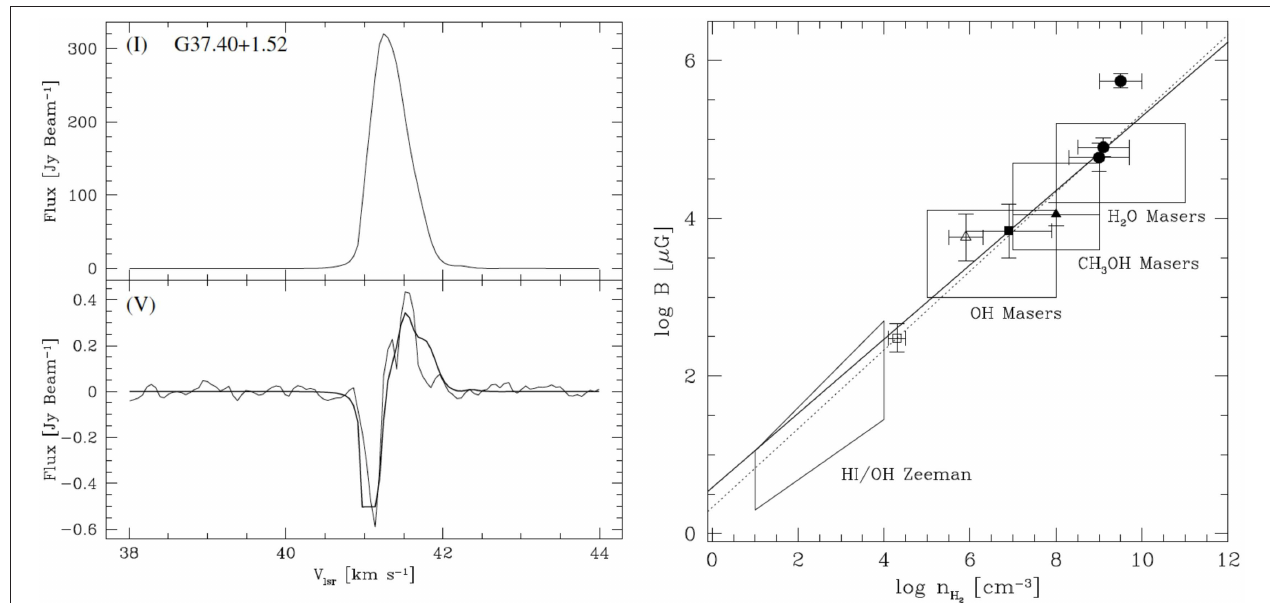
FIGURE 6 | Maser Zeeman results from Vlemmings (2008b). Left : Example of 6.7 GHz methanol maser Zeeman observation. Inferred B LOS = 15.4 ± 0.4 mG. Right : Points with error bars show maser Zeeman inferred values of magnetic field strength in the massive star forming region Cepheus A. Boxes show literature values for maser and extended regions for other regions. Solid line show B ∝ n 0.5 relation while dotted line shows fit to Cepheus A data. Although the slope from this figure seems different from the 0.65 from Figure 5 , the maser slope does not allow for the constant value of field strength for H I Zeeman data. When this is included, the slope for the maser gas is reasonably compatible with 0.65 given the large uncertainties in the gas densities in the maser regions.